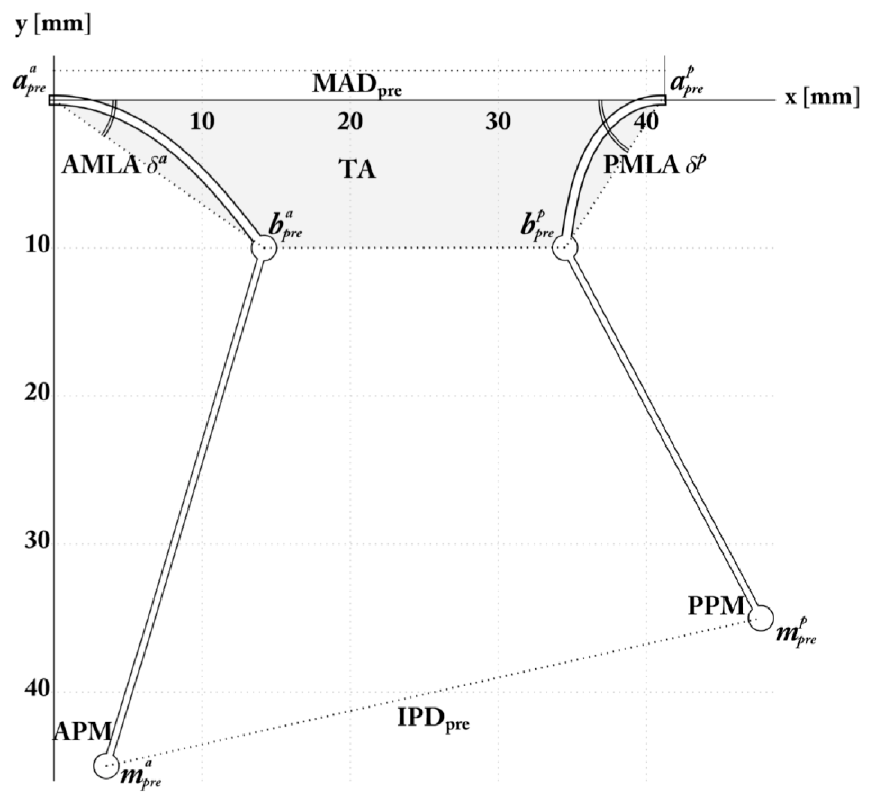
Figure 5. Preoperative configuration determined from the clinical dataset, with the illustration of the considered geometric factors and markers characterizing IMR grade. Table 1. Preoperative geometrical measurements and constitutive parameters, adapted from [4].